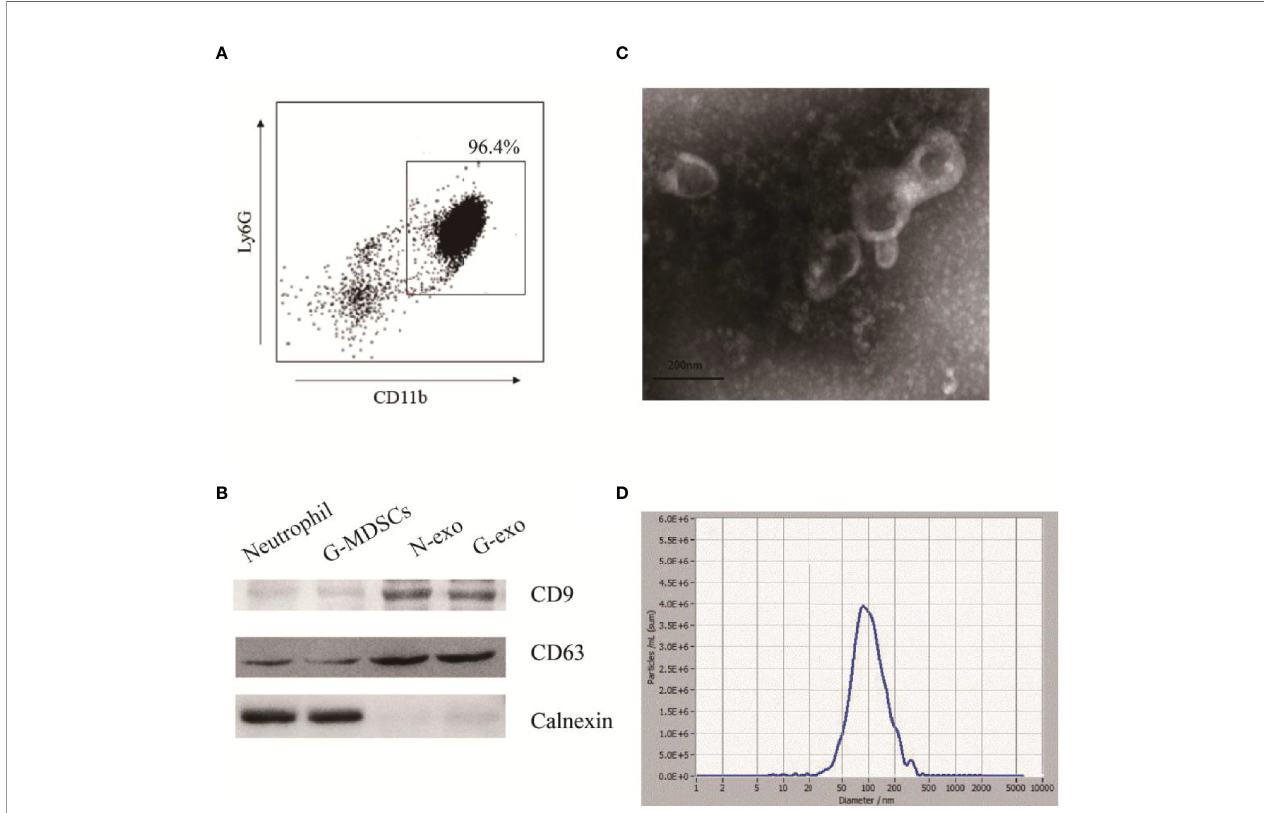
FIGURE 1 | Extraction and identi fi cation of G-exo. (A) G-MDSCs were sorted from mouse spleens using immunomagnetic beads. The expression of Ly-6G and CD11b was analyzed by fl ow cytometry. (B) The expression of CD63, CD9 and calnexin was assessed by Western blot analysis. (C) Representative transmission electron micrograph of G-exo (scale bar = 200 nm). (D) Particle size distribution of G-exo analyzed by nanoparticle tracking analysis (NTA). The presented data are from one of three independent